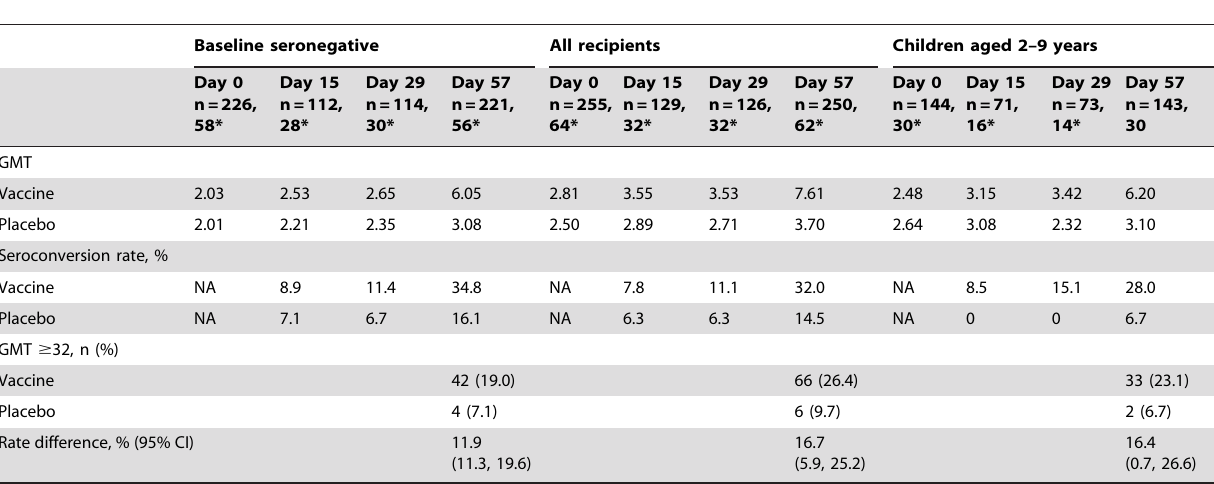
Table 2. Immunogenicity Data for Children 2–17